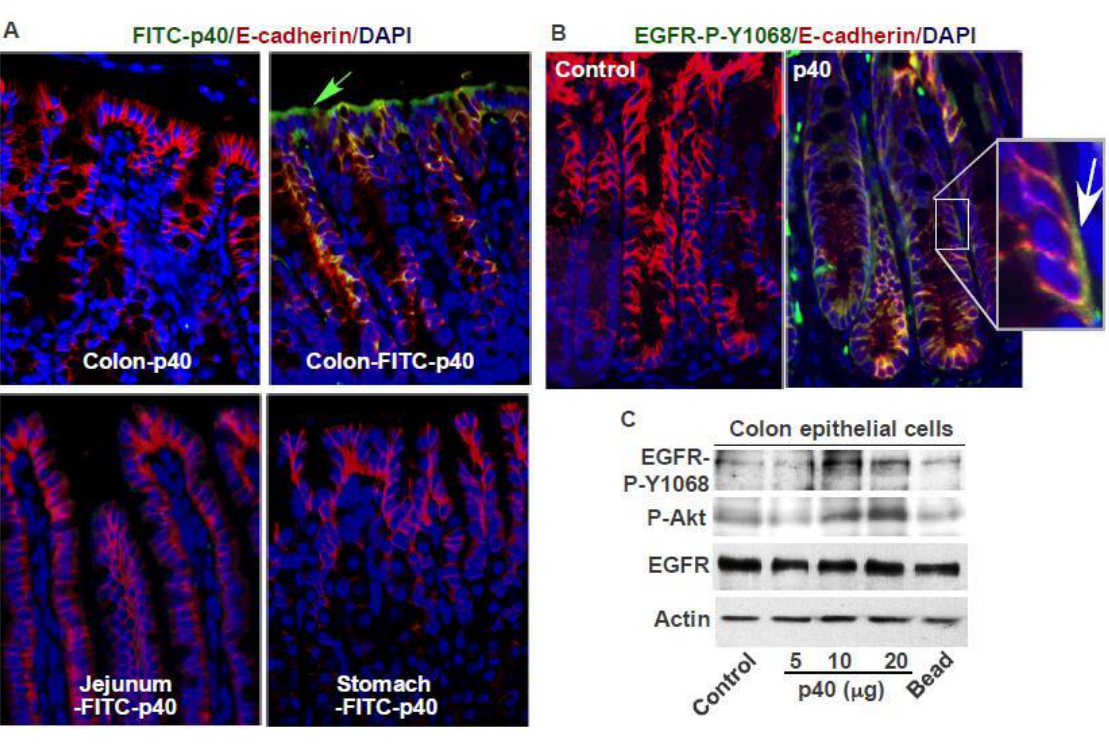
Figure 5. Delivery of p40 to the colon using pectin/zein hydrogel beads activates EGFR in colon epithelial cells. Pectin/zein beads containing p40 or FITC-labeled p40 (10 μg p40 in A and B, or at the indicated dose in ( C ), or pectin/zein beads only without p40 (control) were administered to wt C57BL/6 mice by gavage. Mice were sacrificed 4 h after gavage. Paraffin-embedded tissue sections were prepared for immunohistochemistry to detect p40 delivery (green staining) ( A ), EGFR activation using a rabbit anti-EGFR-phospho (P) Tyr1068 antibody and FITC-conjugated secondary antibody (Green staining) ( B ), an epithelial cell marker using a mouse anti-E-cadherin antibody and Cy3-conjugated secondary antibody (red staining) ( A - B ), and nuclei using DAPI staining (blue staining) ( A - B ). Green arrow in ( A ) indicating FITC-p40 detected in the intestine. The white arrow in ( B ) indicates EGFR-Tyr1068 phosphorylation in cells staining positively for E-cadherin. Colon epithelial cells were isolated for Western blot analysis to detect EGFR and Akt activation